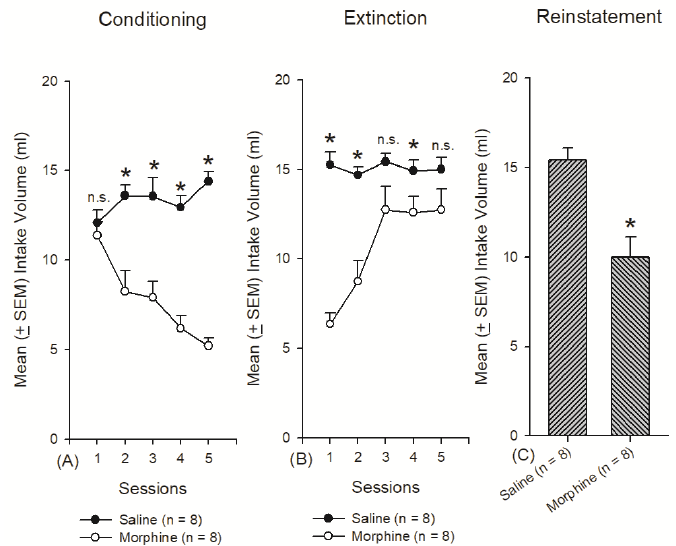
Figure 4. Mean (±SEM) consumption of 0.1% saccharin solution ( A ) for 5 sessions in the condi- tioning phase (with 10 mg/kg of morphine intraperitoneal injections), ( B ) for 5 sessions in the ex- tinction phase (without morphine injections), and ( C ) for the reinstatement test (with a 10 mg/kg morphine injection) across the saline and morphine groups ( n = 8 per group). * p < 0.05 when comparing the saline and morphine groups. saline and morphine groups.